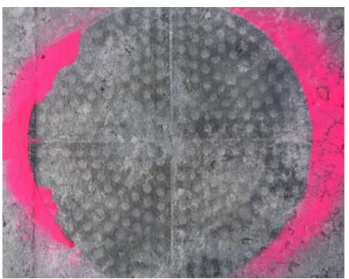
Figure 11. Surface of the test point 5 at the end of the test